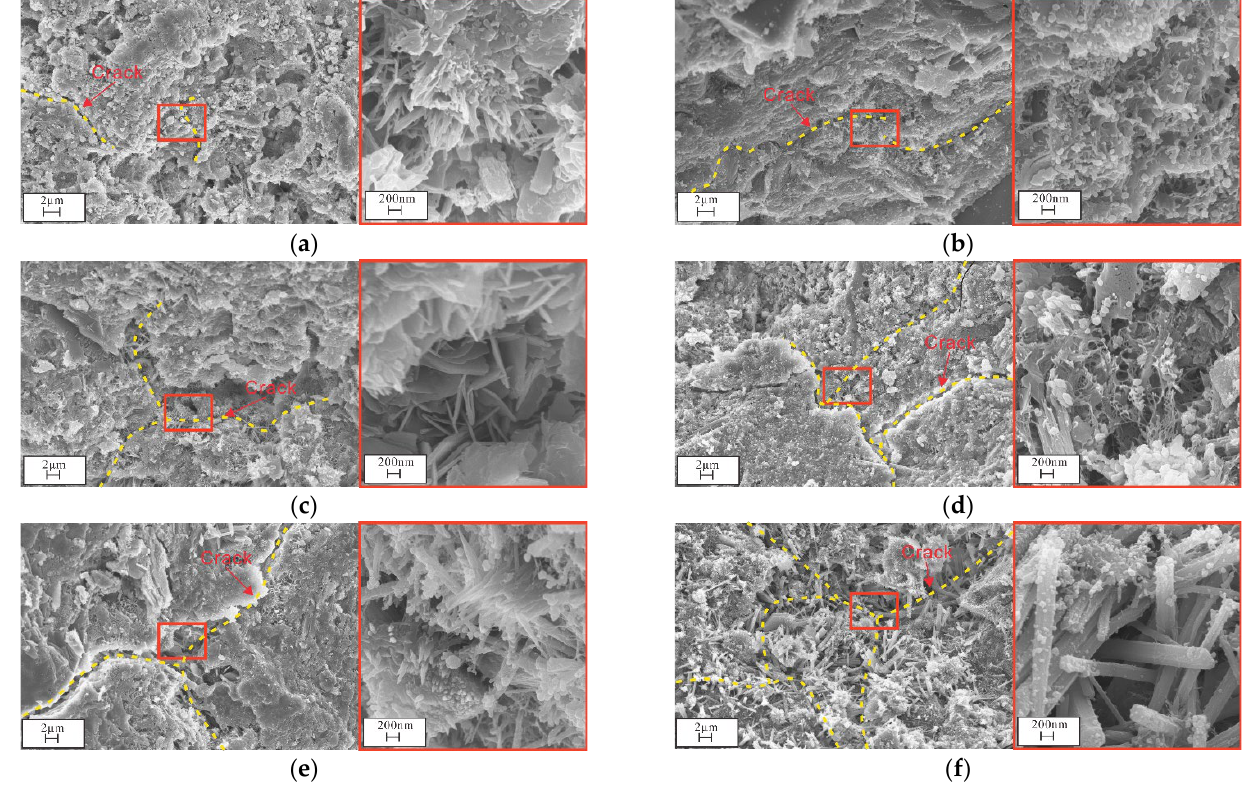
Figure 11. Crack diagrams of samples after 360 d of erosion, ( a ) before erosion; ( b ) C; ( c ) CS0.2-M;